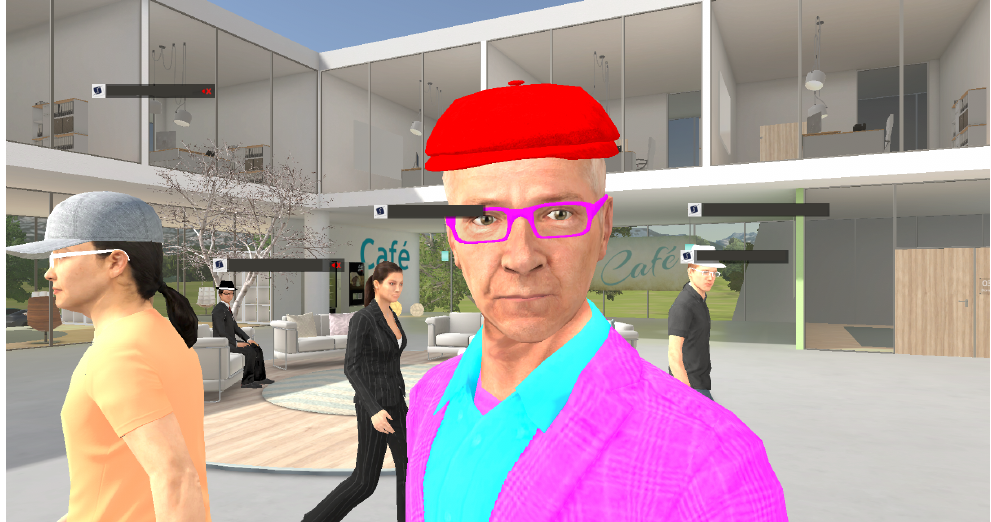
Figure 8. Students moving around the e-CLOSE building in LearnSpace.